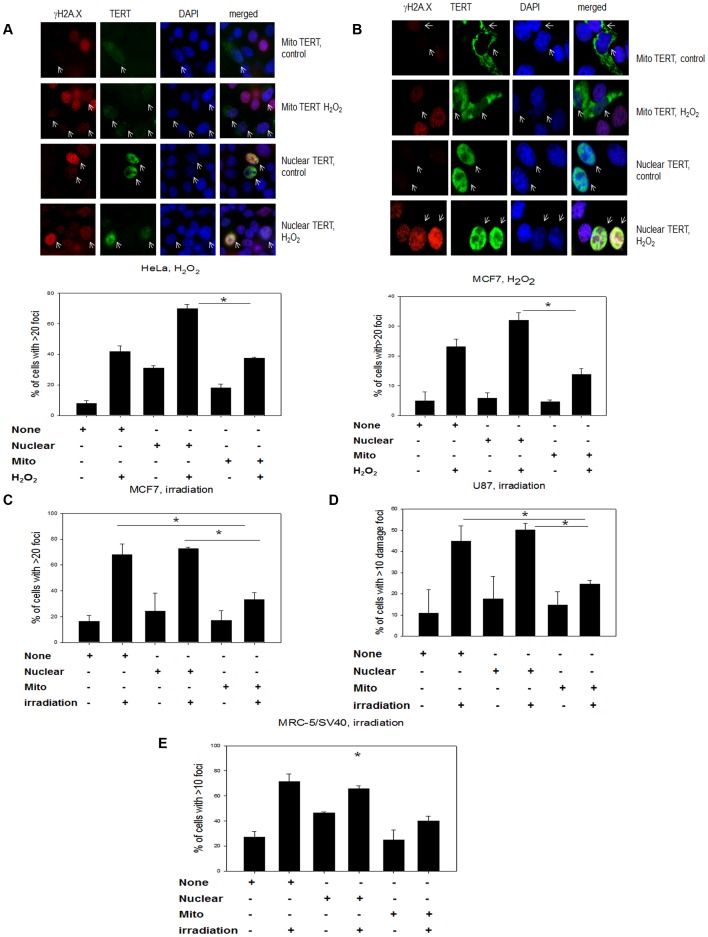
Mitochondrially located TERT reduces nuclear DNA damage afterH2O2
treatment in comparison to nuclear TERT localization in 4 different cell lines. A: Organelle specific TERT vectors transfected into HeLa cells. Upper panel: representative images of cells transfected with mitochondrial and nuclear TERT shooter vectors with and without treatment with 200 µM H2O2 for 3 hours. TERT staining (using myc-tag) fused to TERT protein (green) and γH2A.X staining (red) for DNA damage foci. Arrows show transfected cells. Lower panel: Quantification of cells with high levels of DNA damage foci for transfected and un-transfected cells with and without H2O2 treatment. Bars are mean ± SE from 3 independent experiments, *P<0.05. B: Organelle specific TERT vectors transfected into MCF7 cells. Panels as described for A. C–F: Quantification of cells with high levels of DNA damage foci for transfected and un-transfected cells with and without x-irradiation. C: MCF7 after 20 Gy X- irradiation. D: U87 after 20 Gy X-irradiation. E: MRC-5/SV40 after 10 Gy X-irradiation. Bars are mean ± SE from 3 independent experiments. * P<0.05.